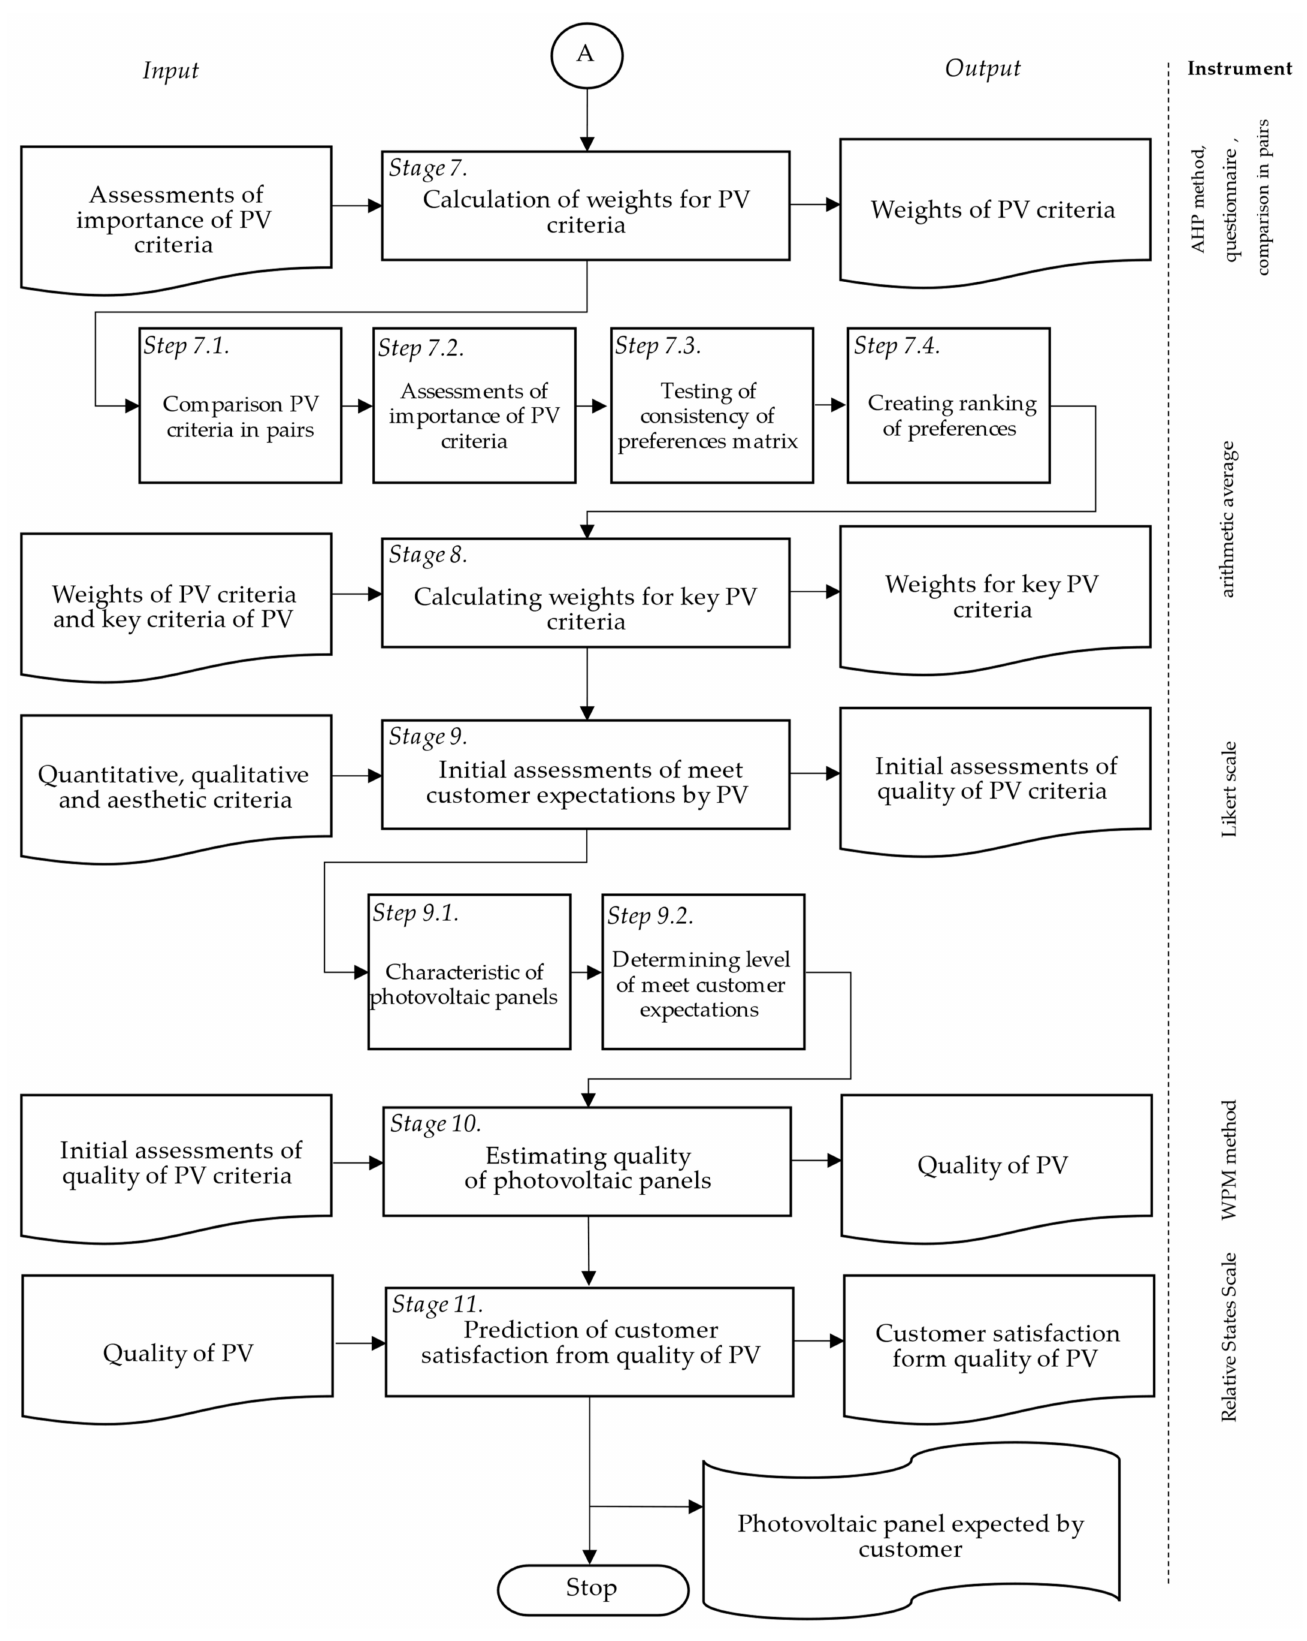
Figure 4. Model of prediction of quality photovoltaic panels—part 2. Own study. The characteristic of stages of the model is presented in the next part of the